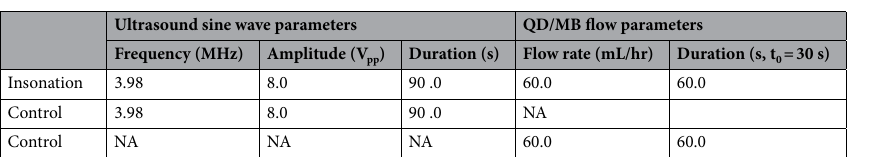
Table 5. In vivo porcine experimental parameters.